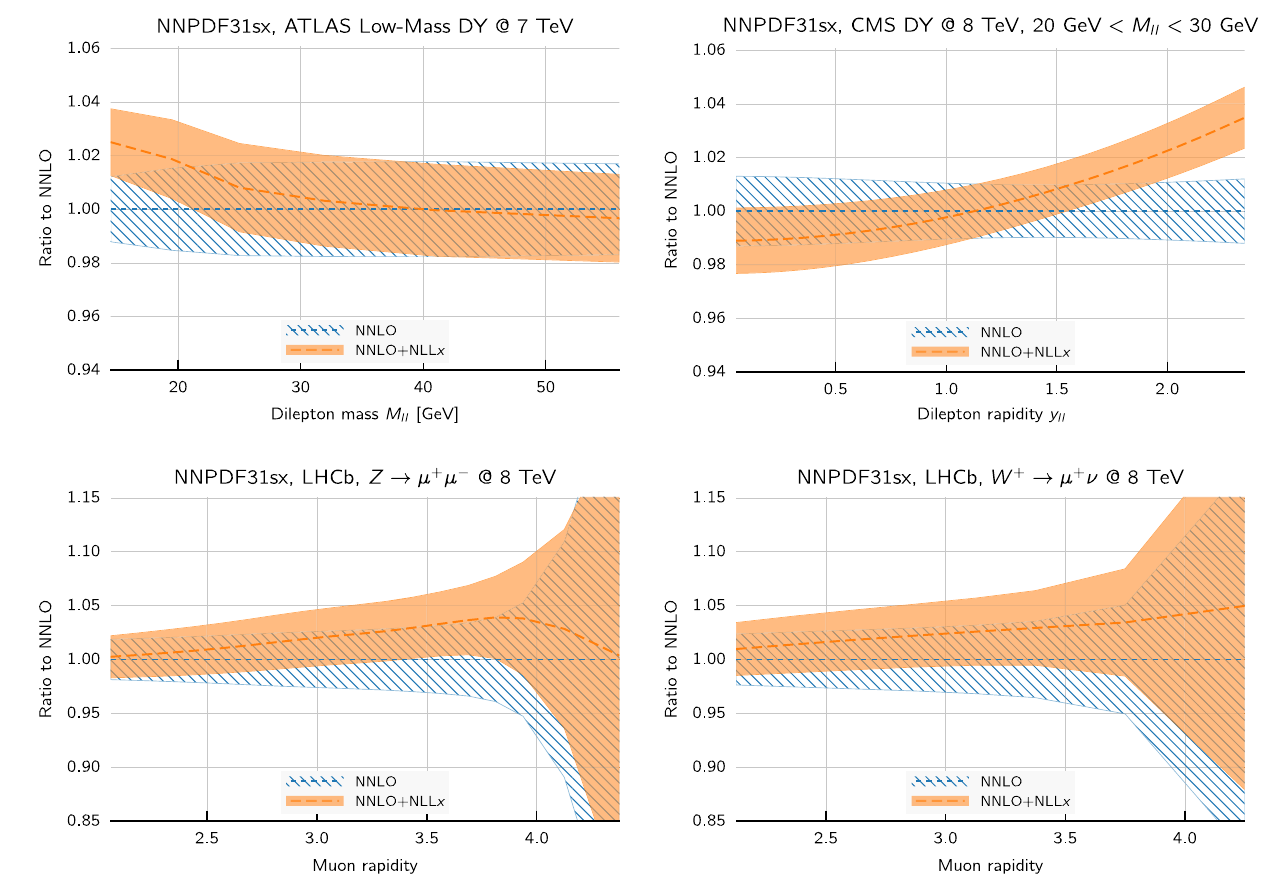
measurements at 8 TeV, and the LHCb W + and Z rapidity distributions at 8 TeV. For the NNLO+NLL x predictions, the effects of small- x resummation are included in the PDF evolution but not in the partonic